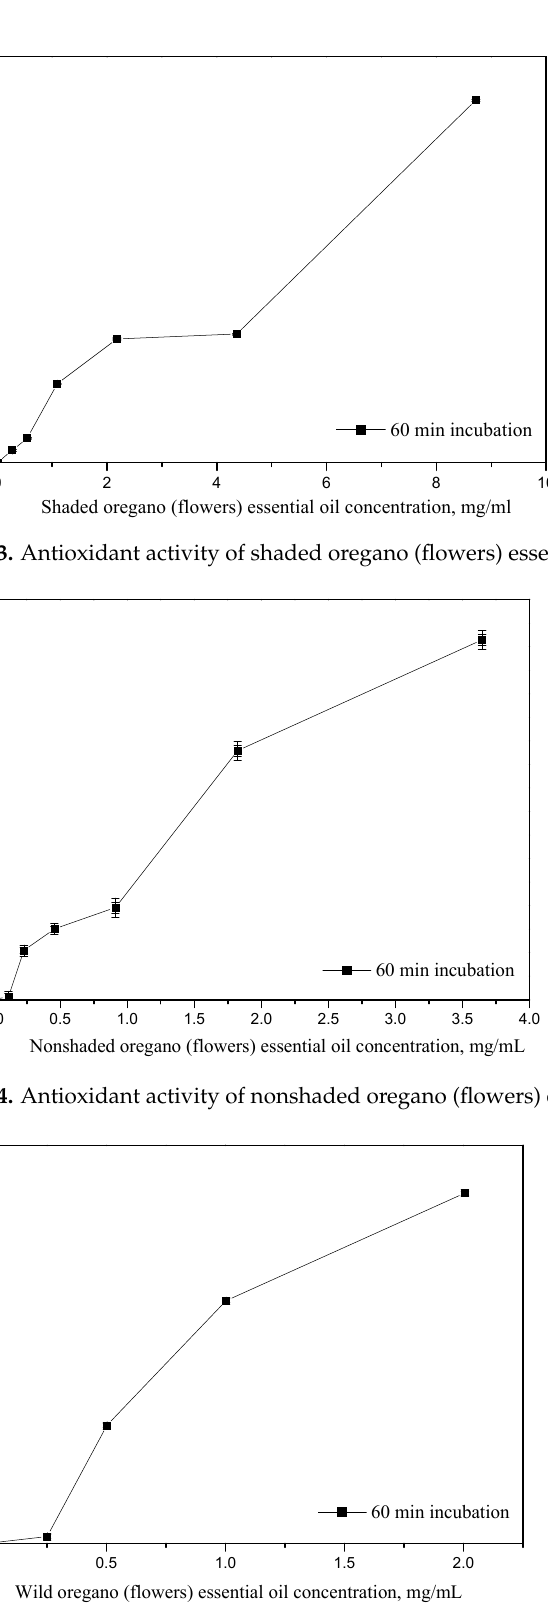
Figure 2. Antioxidant activity of nonshaded oregano (stems and leaves) essential oil.